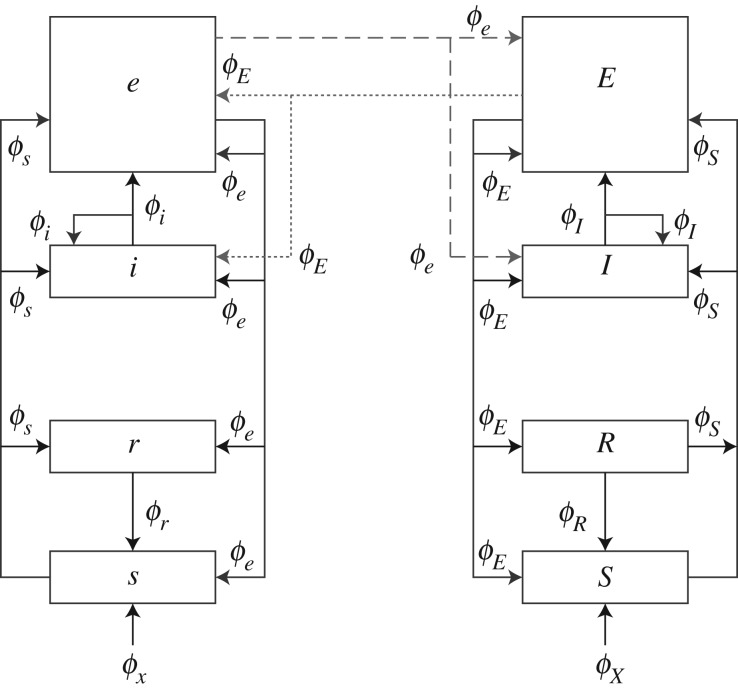
Schematic bihemispheric corticothalamic system showing activity fields ϕa emerging from left hemisphere populations and ϕA from right hemisphere populations, with corresponding synaptic gains Gab as shown. Connections between populations are shown as arrows. Populations represent cortical excitatory pyramidal (e, E), cortical inhibitory (i, I), thalamic reticular (r, R), thalamic specific relay (s, S) and external (x, X). (Figure adapted from [8].)